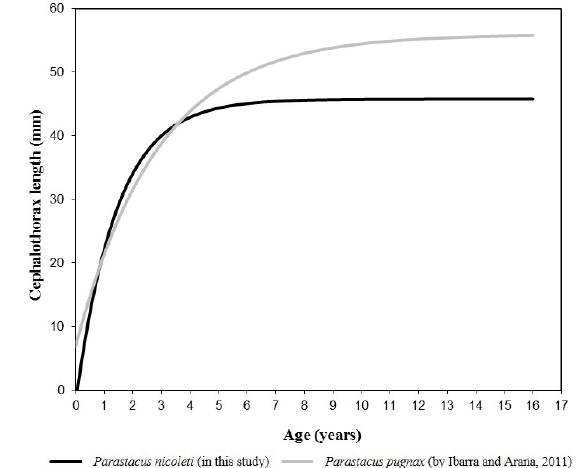
Figure 3. Weight growth curve of the burrowing crayfish Parastacus nicoleti adjusted to the von Bertalanffy (1938) model.